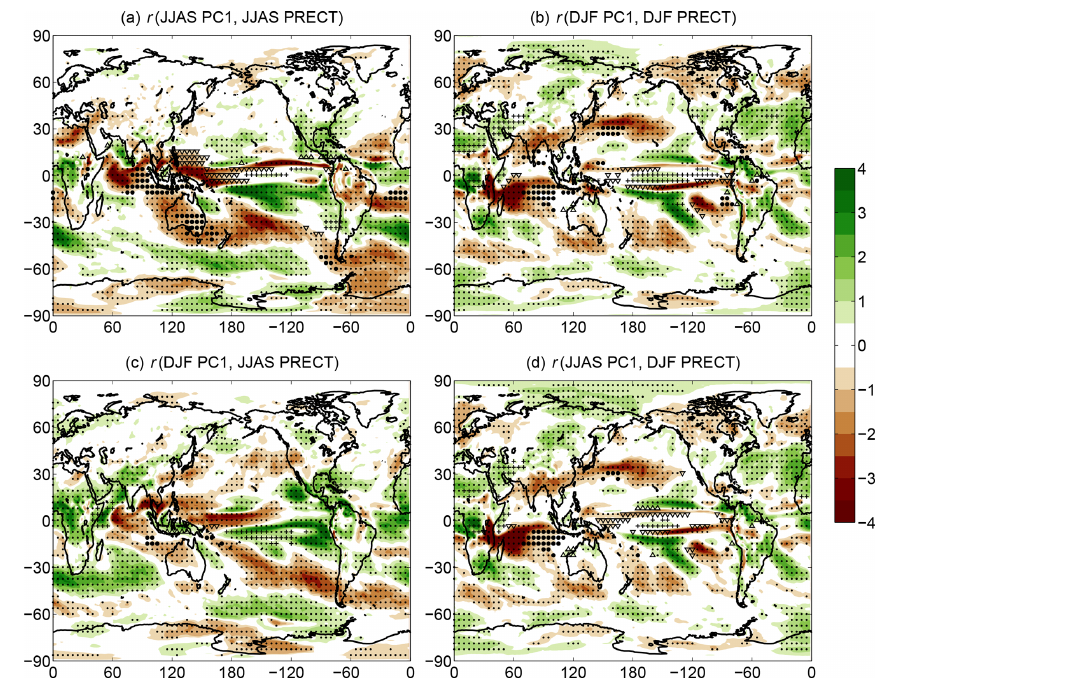
Figure 5. The slope of the linear fits (10 − 3 yr − 1 ) at each grid point for the correlation coefficient r for the (a) JJAS PC1 and JJAS PRECT, (b) DJF PC1 and DJF PRECT, (c) DJF PC1 and JJAS PRECT, and (d) JJAS PC1 and DJF PRECT. Dots represent geographical locations where the trend is significant at the 95% level. In addition, (i) where the trend is positive and the correlation coefficients are positive and significant at the 95% level in the temporal mean, “ + ” signs are displayed, (ii) where the trend is positive and the correlation coefficients are negative and significant at the 95% level in the temporal mean, “ (cid:52) ” signs are displayed, (iii) where the trend is negative and the correlation coefficients are positive and significant at the 95% level in the temporal mean, “ (cid:79) ” signs are displayed, and (iv) where the trend is negative and the correlation coefficients are negative and significant at the 95% level in the temporal mean, “ • ” signs are displayed, respectively. For better visibility, the significance and direction of the trend is indicated at only every fourth grid